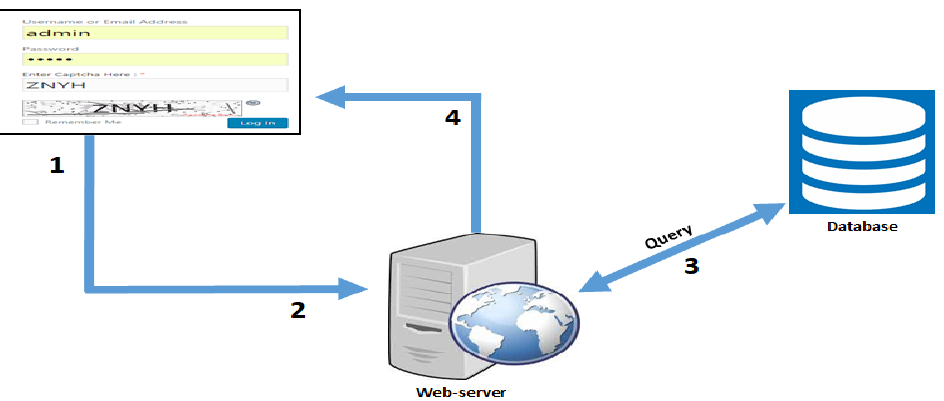
Figure 2. Proposed system model.